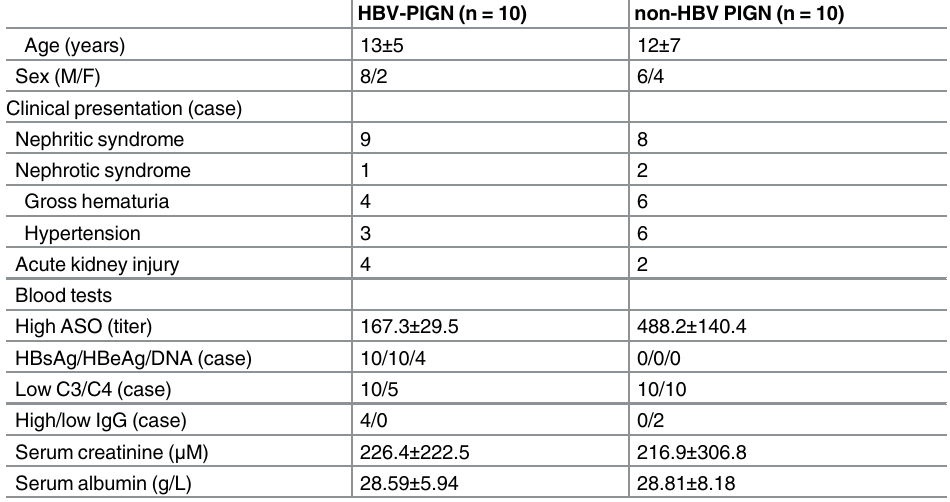
Table 1. General charactersitics of patients with HBV and non-HBV associated PIGN.